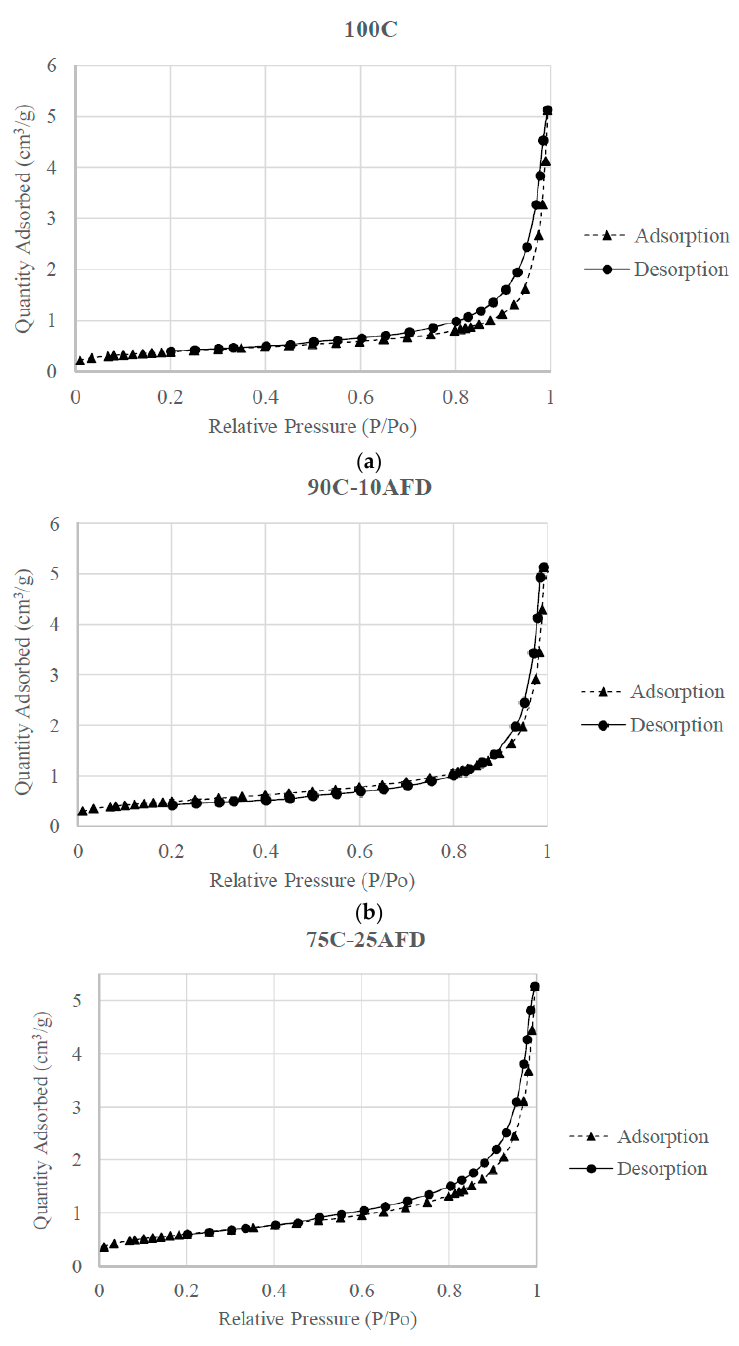
Figure 5. Adsorption-desorption isotherms of N 2 at 77 K of fired clay bricks (( a ) 100C; ( b ) 90C-10AFD and ( c ) 75C-25AFD). Table 4. BET surface, micropore area, BJH cumulative volume of pores, and BJH average pore diameter for clay-aluminum filter dust bricks.